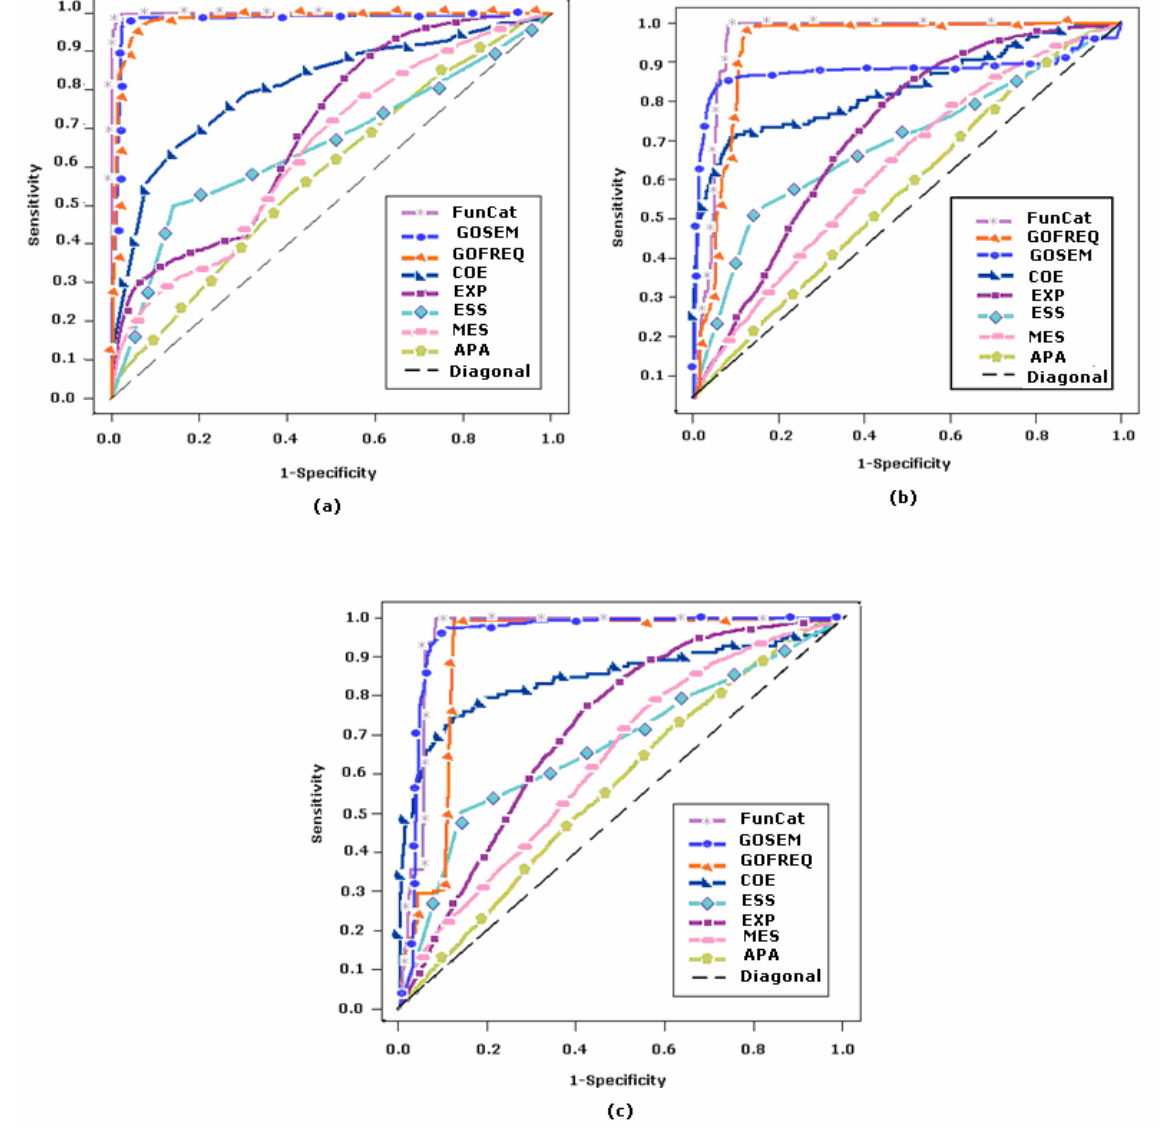
Figure 1. The panels a-c each represent the predictive power of individual features (datasets) using each predictive model. The results are displayed in a ROC curve where we plot Sensitivity against (1-Specificity). The predictive models are displayed as follows (a) KNN. (b) MLP. (c)